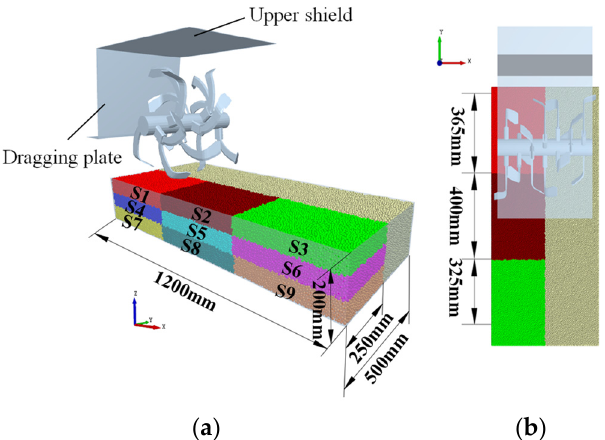
Figure 4. Simulation model: ( a ) soil bin model ( b ) tillage distance.